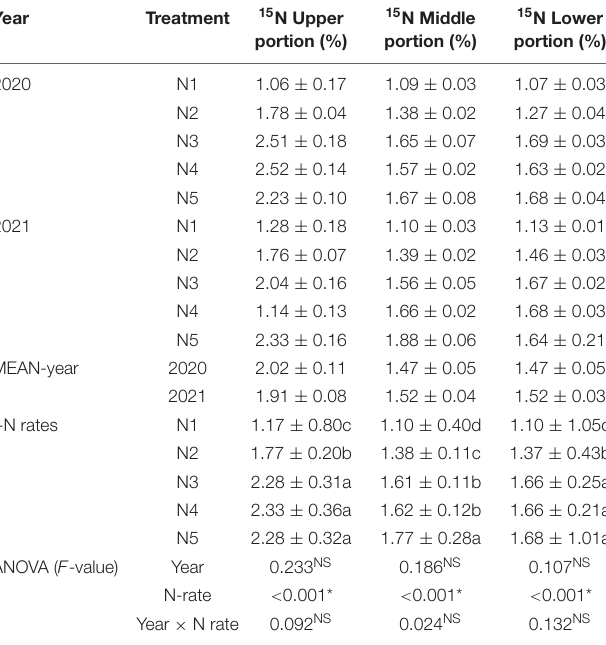
TABLE 1 | Effect of N fertilizer on isotope values of 15 N excess (in atom percent) in the upper, middle, and lower portions of shoots in spring